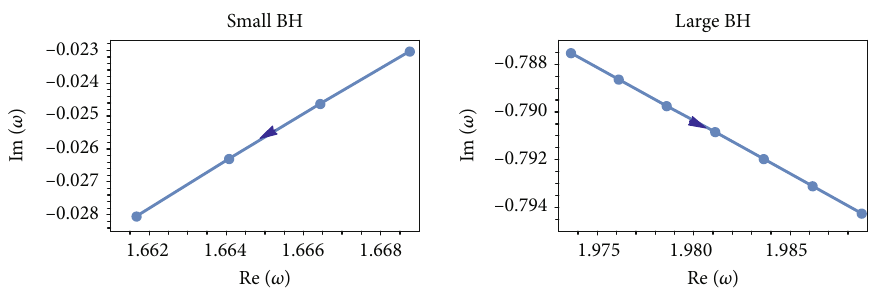
= − 2/3 . The arrow denotes the increase in r s